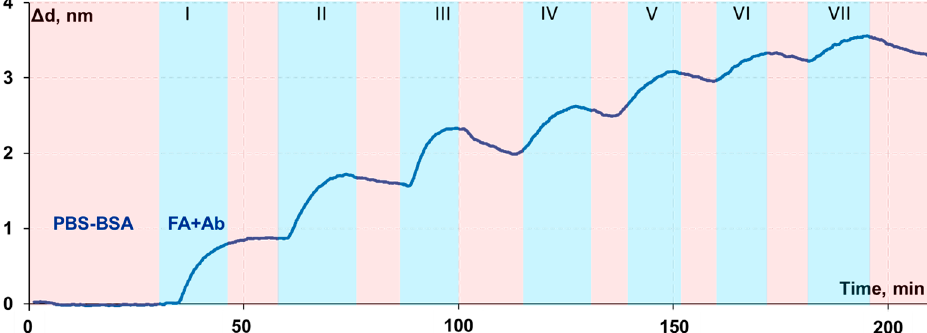
Figure 7. Stepwise filling of the attachment sites on the sensor chip by application of gradually decreasing concentrations of free FA in solutions containing FA antibody at 7 µg/mL (concentrations of free FA: I—22,650 pM, II—4500 pM, III—900 pM, IV—180 pM, V—36 pM, VI—7.2 pM, and VII—1.4 pM).